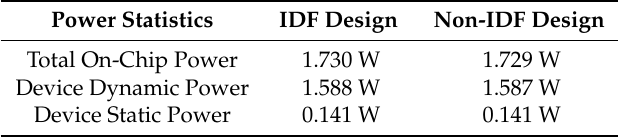
Table 4. Power Consumption of IDF and Non-IDF